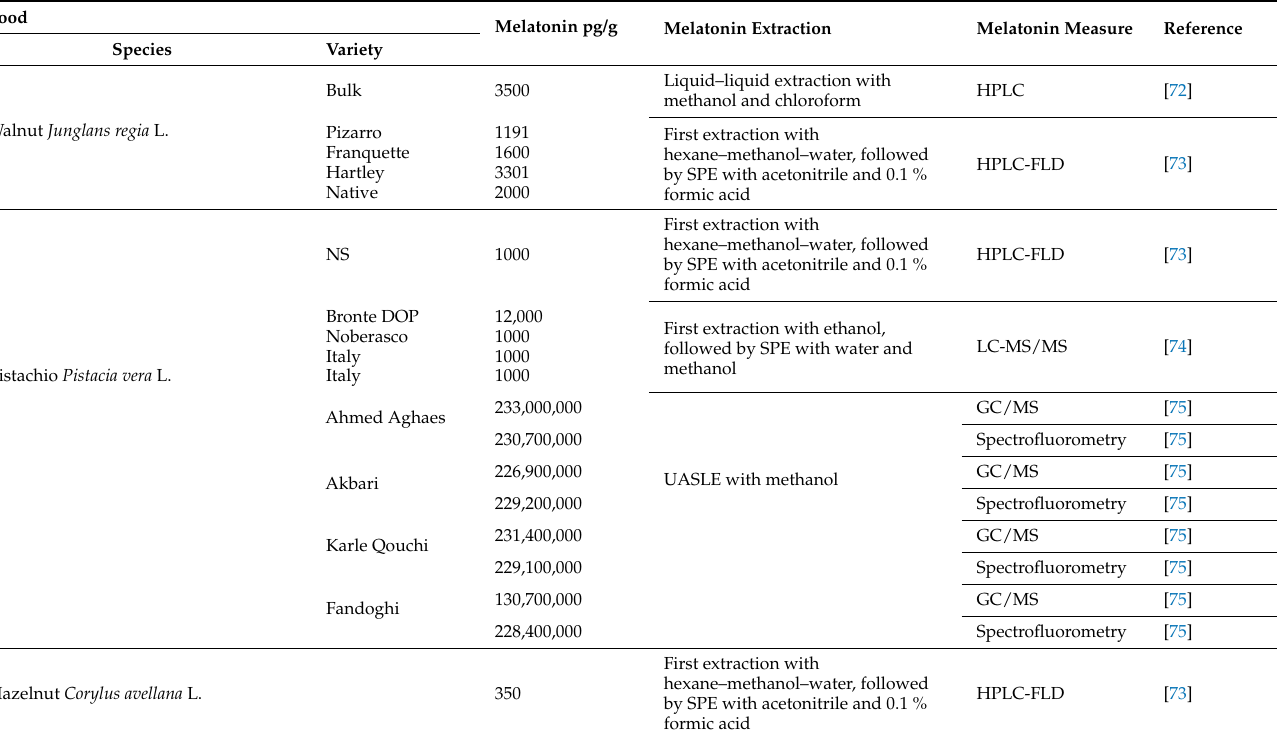
Table 3. Melatonin content in nuts and